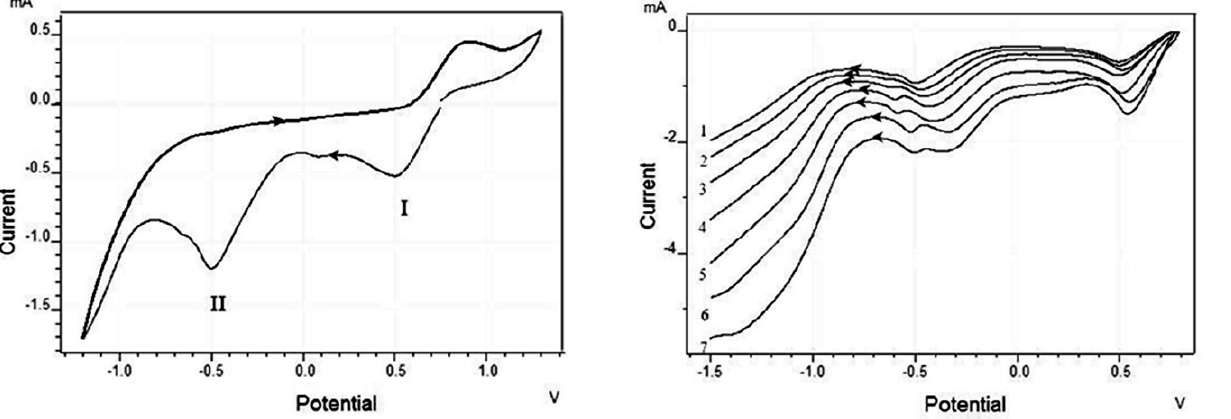
Majidzade et al.: Electrodeposition and Growth of Iron ...